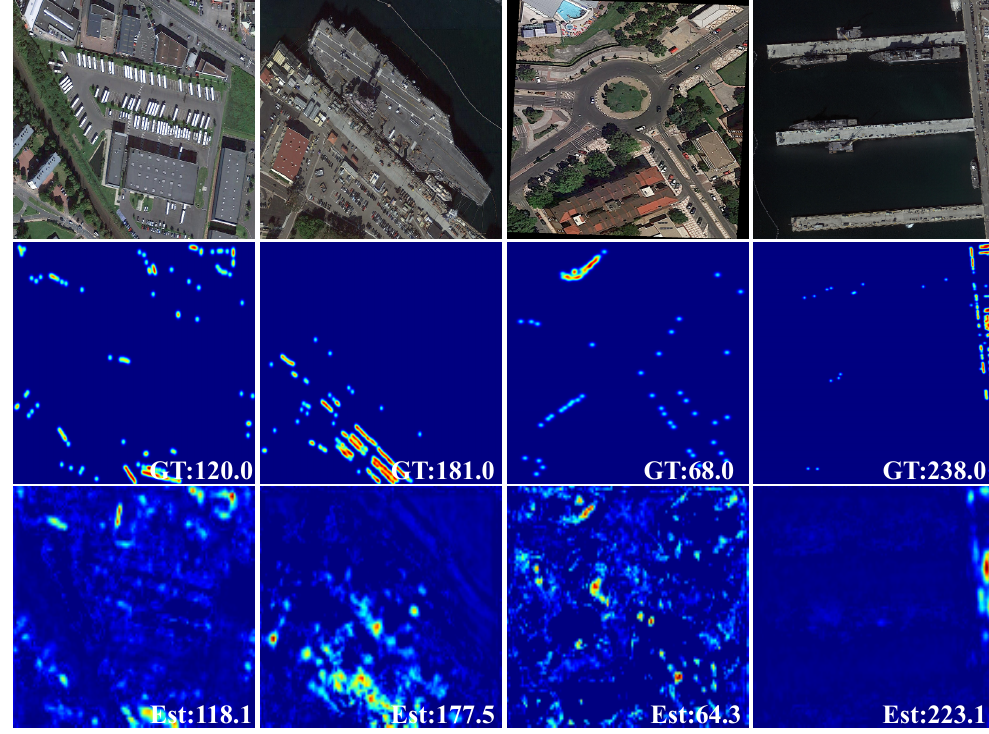
Figure 7. Subjective results on the RSOC_small-vehicle subdataset.